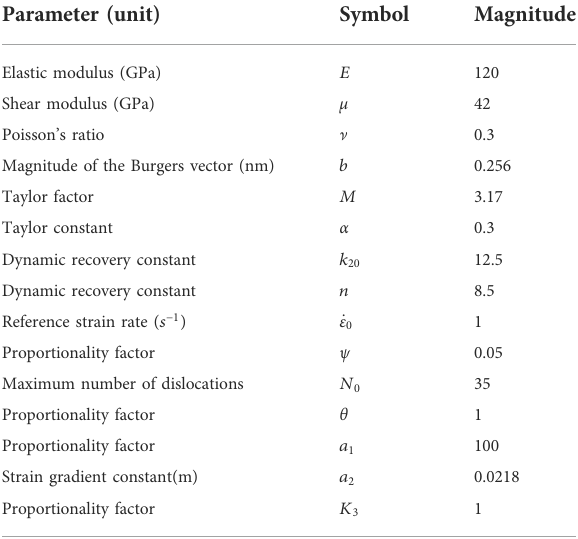
TABLE 1 Descriptions, symbols and magnitudes of different material parameters of the